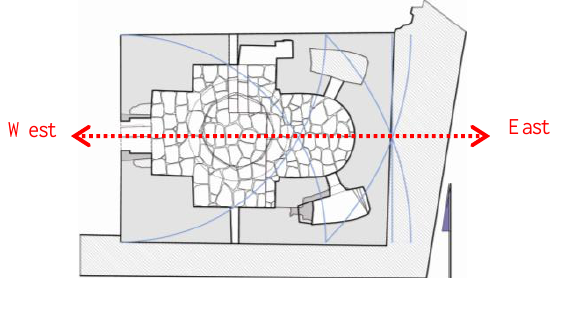
Figure 7. Chupan Church